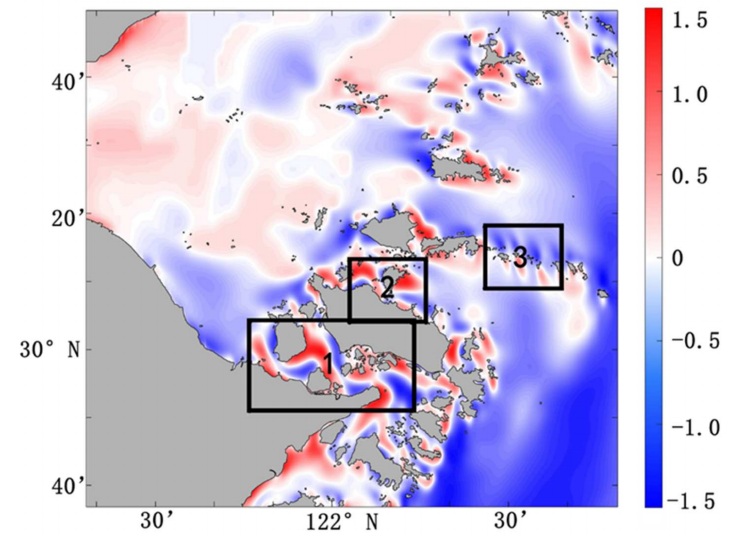
Figure 8. The TCA estimated using the skewness of the tidal current in the Zhoushan Islands.